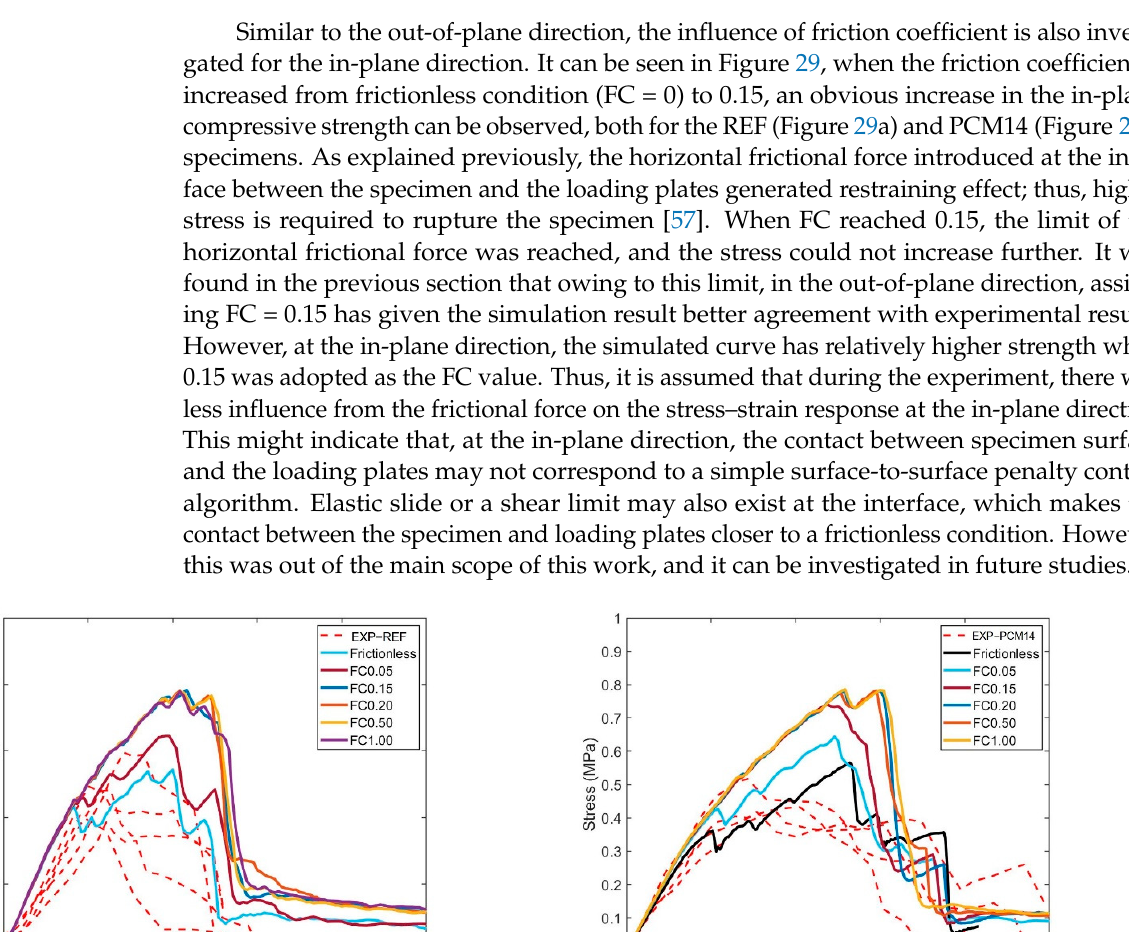
Figure 28. In-plane stress–strain curves of ( a ) R7-REF and ( b ) R7-PCM14; note that the y-axes of the two figures are different.